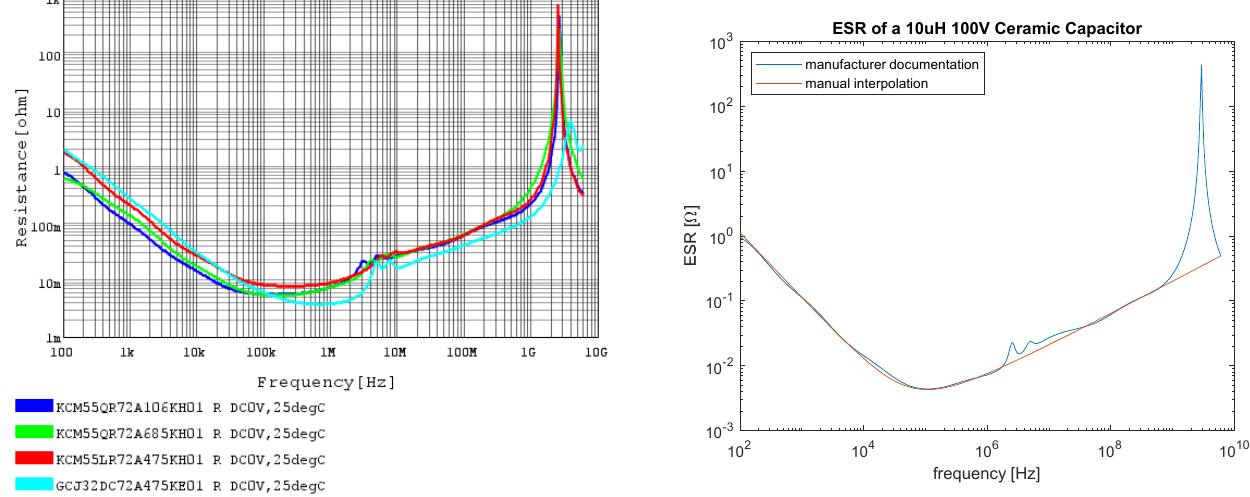
Figure 14. Ceramic capacitor equivalent series resistance with respect to frequency. ( Left ), manufacturer data, ( right ), equivalent model representation for the series resistance with respect to frequency.